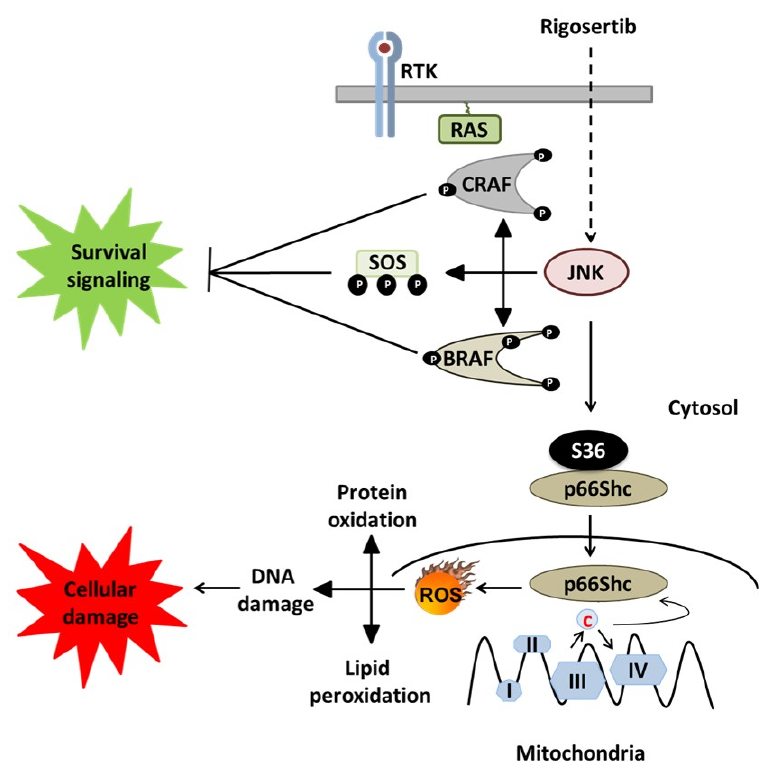
Figure 6. Rigosertib-mediated cell death pathways (modified from Ritt et al. [7]). Work by Ritt et al. identified the effect of Rigosertib-induced JNK activation on the suppression of the RAS signaling pathway and consequent blunting survival and growth signals. Our data point to an additional mechanism, which may be even more common, linking activated JNK1/2 to the activation of p66Shc, which has been implicated in ROS-mediated cell death under various conditions [12].